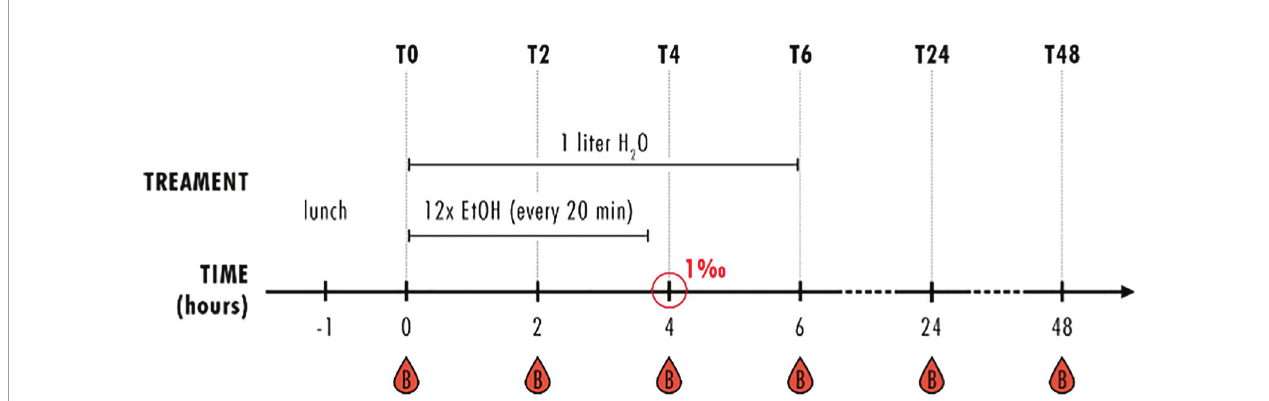
FIGURE 1 | Study design. Healthy volunteers (HV) received a standardized lunch one hour before starting the experiment and had one liter water at hand during the fi rst observation period of 6 hours (T0-T6). Every 20 minutes, HV received an individually calculated amount of whisky-coke cocktail (EtOH) for four hours, reaching blood alcohol concentration of 1 ‰ after 4 hours (T4). Blood samples were collected before (T0) and 2 (T2), 4 (T4), 6 (T6), 24 (T24) and 48 (T48) hours after starting the alcohol consumption. This is the same study design as published by Sturm et al.